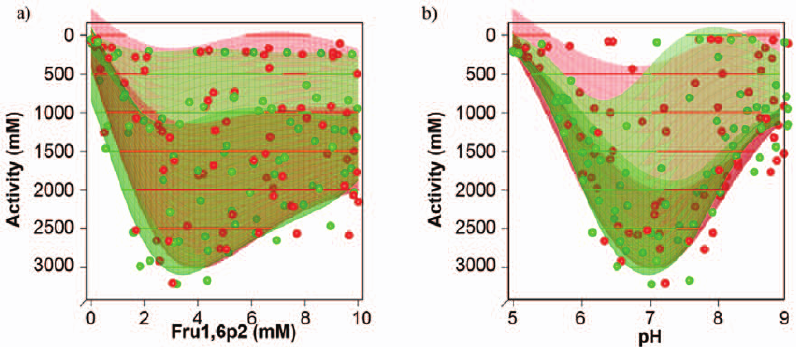
Figure 3. Comparison of PYK activities determined with fixed and variable KCl concentrations. a) and b) show two different perspectives of the same plot. The data shown in red is from the first round of the experiment described in 3.2 and identical to that shown in Fig. 9. The data in green was measured directly at the KCl concentration of the slice of the Kriging model from round one. The fit-surfaces of two datasets are very similar, indicating that the interpolation from the variable KCl model gives a good prediction of the activities at the optimal KCl concentration.